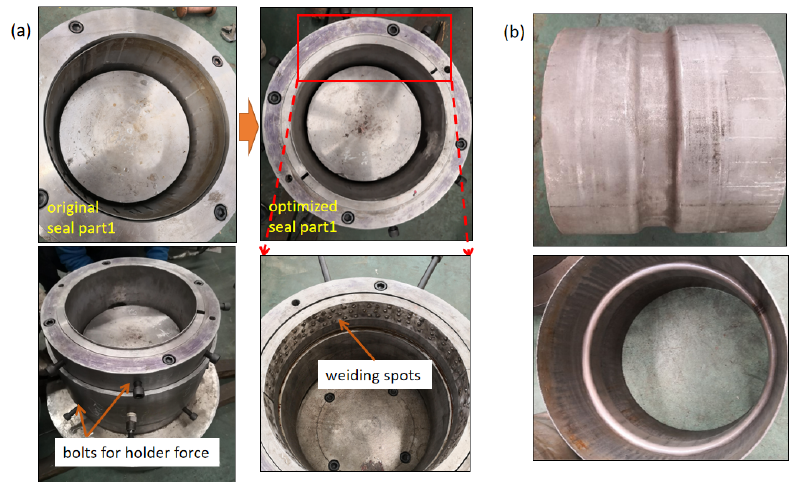
Figure 23. The improvement of controlling material flowing: ( a ) die optimization and ( b ) fine component.